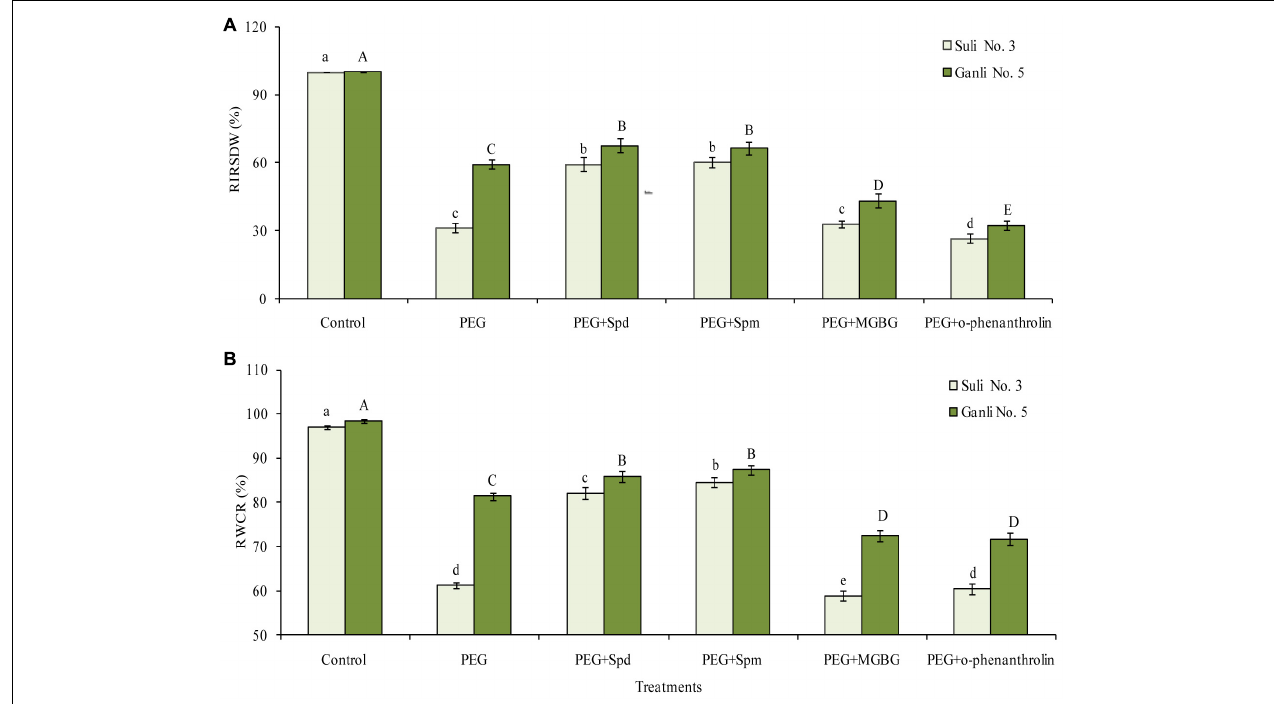
FIGURE 2 | Changes in RIRSDW (A) and RWCR (B) of plum seedlings under PEG, exogenous Spd, Spm, MGBG, and o-phenanthroline. Control: treatment without PEG or the other reagents (–0.15 MPa); PEG: treatment with PEG (–0.85 MPa); PEG + Spd: treatment with PEG and Spd (1 mM); PEG + Spm: treatment with PEG and Spm (1 mM); PEG + MGBG: treatment with PEG and MGBG (0.5 mM); PEG + o-phenanthroline: treatment with PEG and o-phenanthroline (0.2 mM). The data here were means ( n = 9) ± standard error of 3 independent experiments. Significant differences between treatments are indicated with letters, with upper and lower letters for each cultivar ( P <